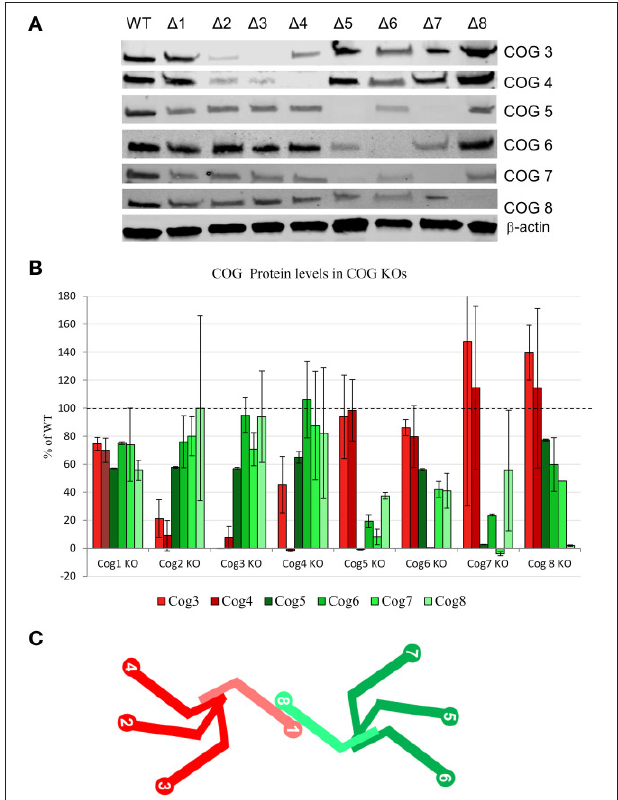
FIGURE 3 | COG protein stability upon loss of other COG proteins. (A) All COG KO cells were probed by western blot for Cog3, 4, 5, 6, 7, and 8 protein levels. β -actin used as a loading control. (B) Quantification of 2 separate western blot analyses. Each Cog protein amount was first standardized to β -actin then compared to WT levels. (C) A model of COG subunit interactions. lobe A is shown in shades of red and lobe B is shown in shades of green. Cog1 and Cog8 are lighter in color to show that they also gain stability from one another in addition to their lobe